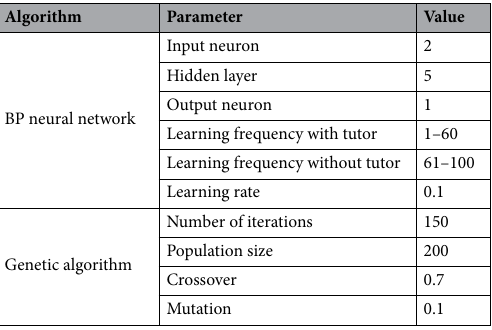
Table 2. Settings of genetic algorithm and BP neural network.